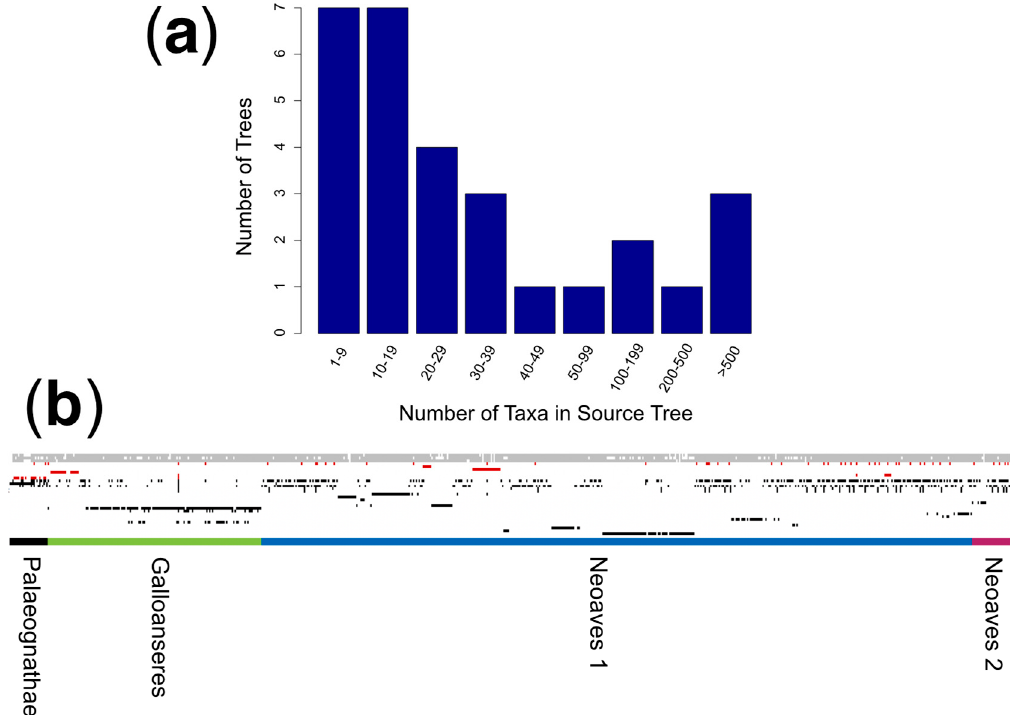
Figure 2. Taxon sampling for phylogenomic studies. ( a ) Histogram showing the number of taxa in each source tree. ( b ) Matrix occupancy graph. Lines indicate taxa present in each source tree. Taxa are sorted taxonomically, first by major clade (bar at the bottom of the graph) and then by order. Most taxa are present in at least one of the backbone trees (gray, top of the graph). In contrast, many phylogenomic source trees (black and red) have limited taxonomic overlap; this is especially true for trees based on whole-genome sequencing data (red). It is also clear that many phylogenomic trees are limited to specific taxonomic groups.